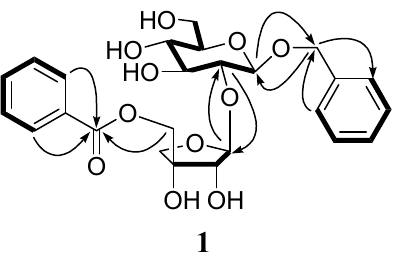
Figure 2. Key COSY ( ) and HMBC ( → ) correlations of